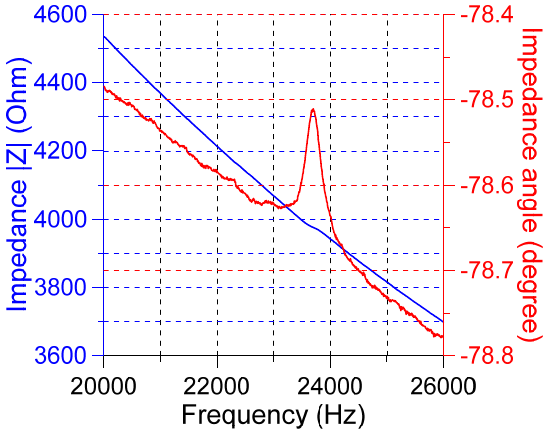
Figure 10. Measured electrical impedance of the PMUT device for the open-cavity case.